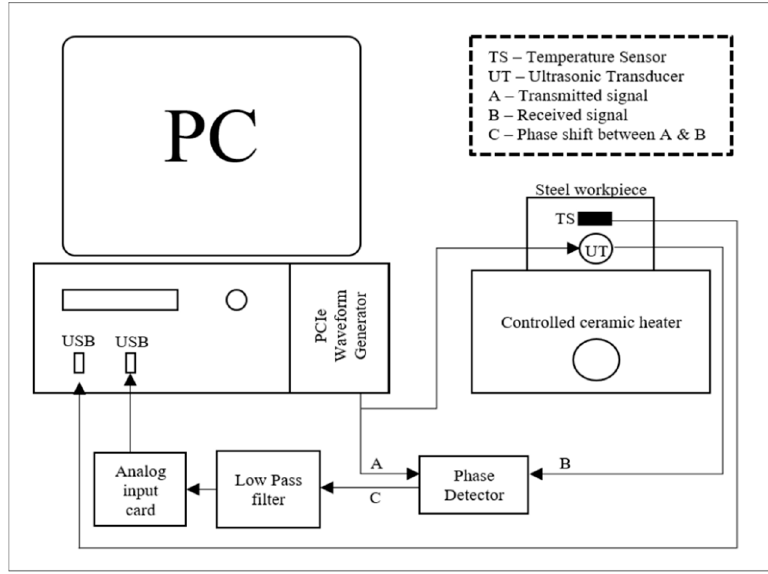
Figure 6. Ultrasonic phase-shift experimental setup.